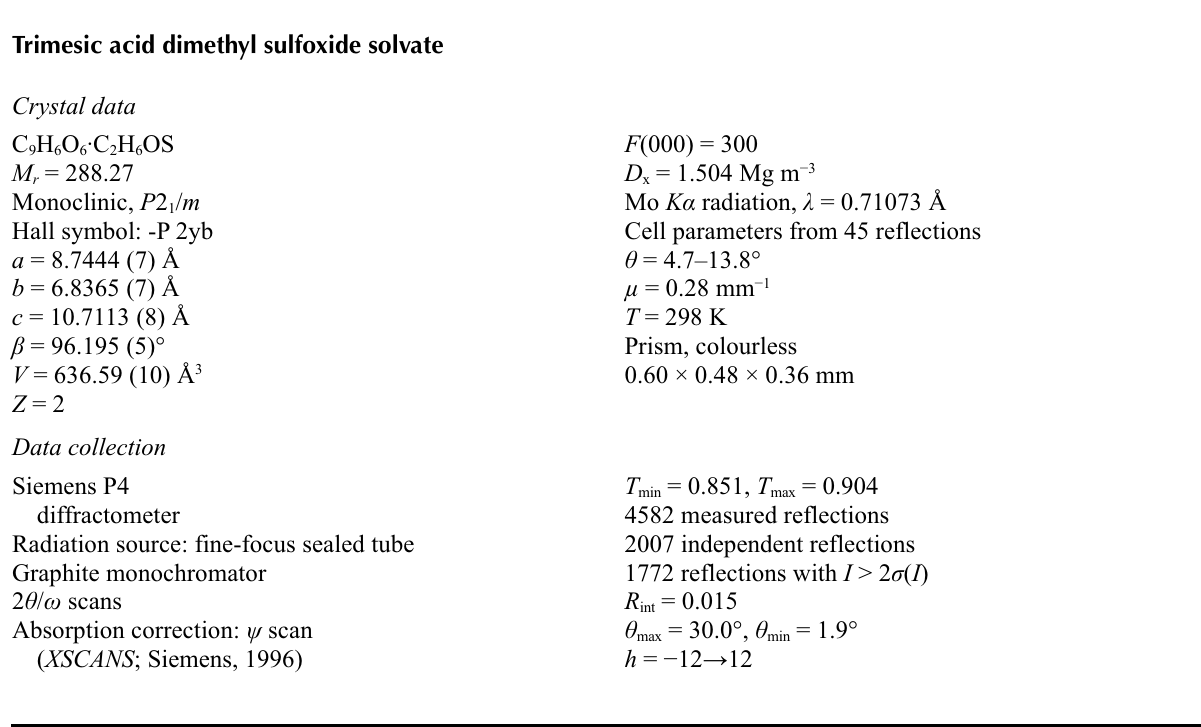
Figure 2 A part of the packing structure for the title compound, viewed approximately along [010]. The hydrogen bonds forming the two-dimensional supramolecular network are depicted by dashed